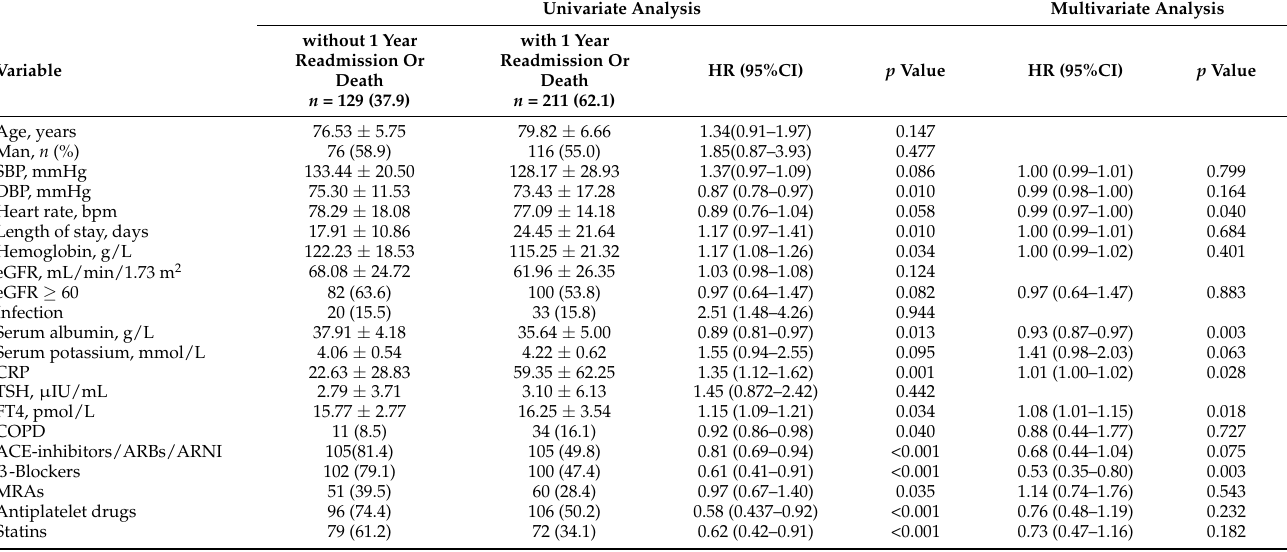
Table 4. Patient characteristics and multivariate analysis of factors for 1-year all-cause readmission or death in elderly HF patients with prior ischemic stroke. Univariate